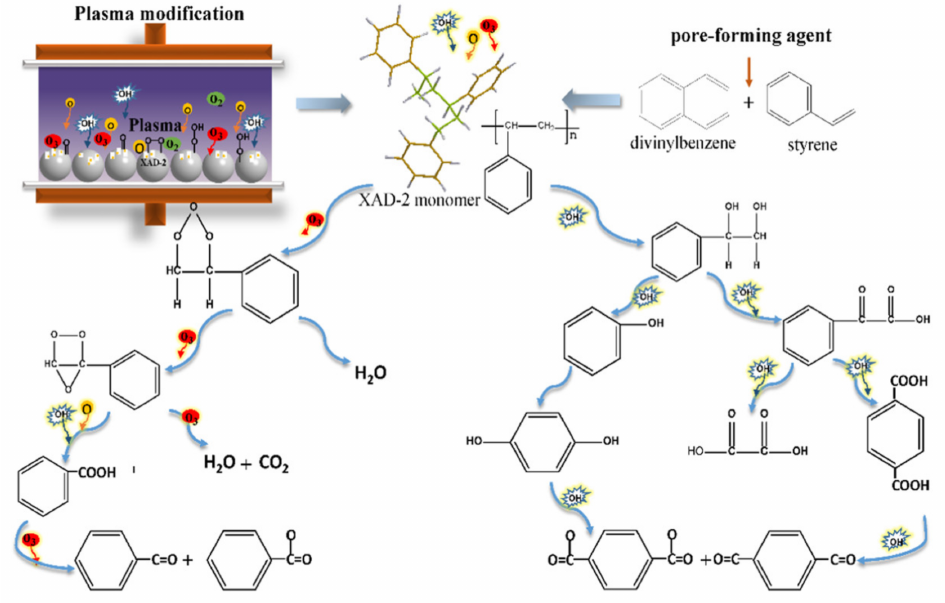
Figure 6. Proposed pathways for XAD-2 resin polymerization and functionalization of XAD-2 resin with active species in the